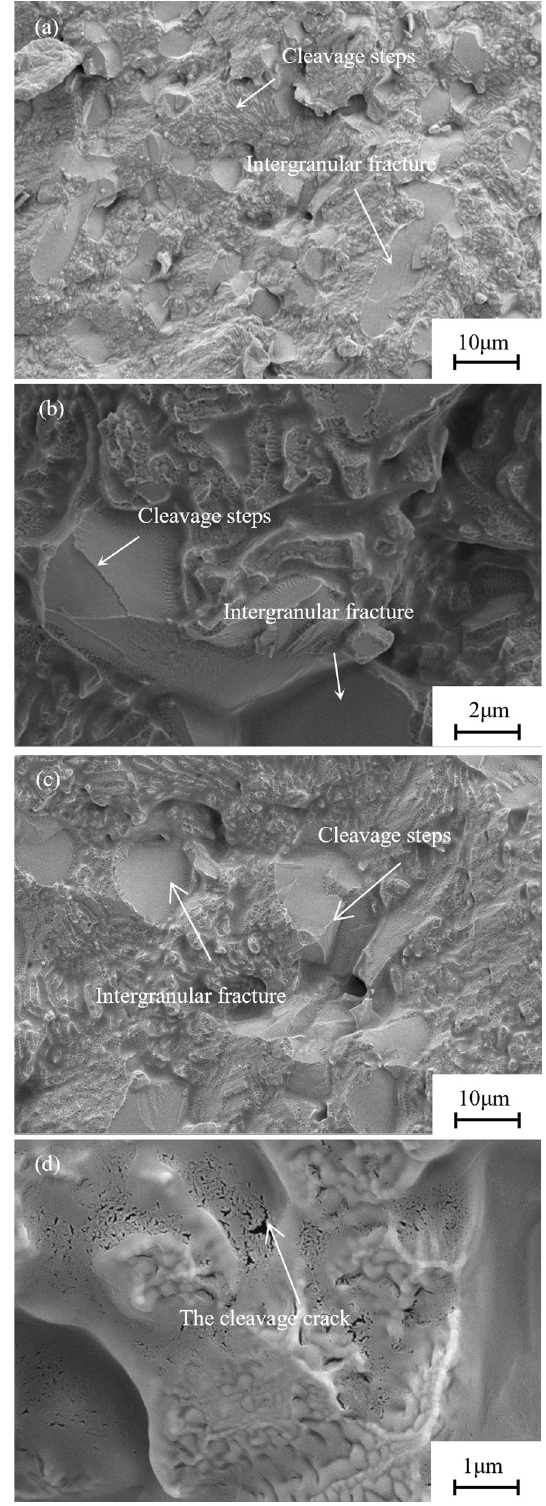
Figure 5: SEM images of the compression fracture of FeCoCrNiMo alloy: ( a ) As - cast, ( b ) AT - 873 K, ( c ) AT - 1,073 K, and ( d ) AT - 1,273